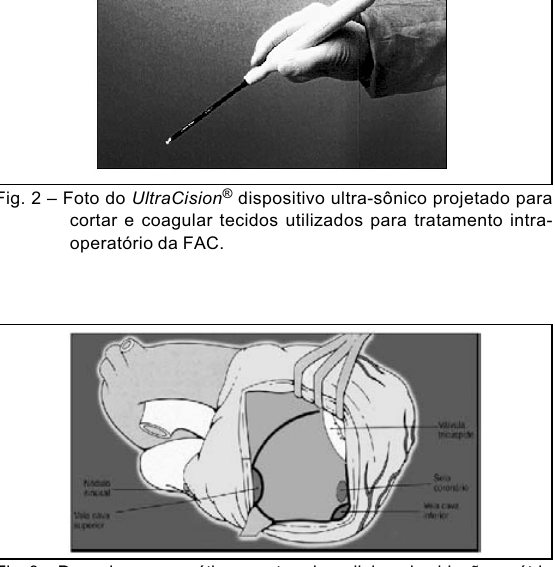
Fig. 3 – Desenho esquemático, mostrando as linhas de ablação no átrio direito, para tratamento intra-operatório da FAC com ultra-som.